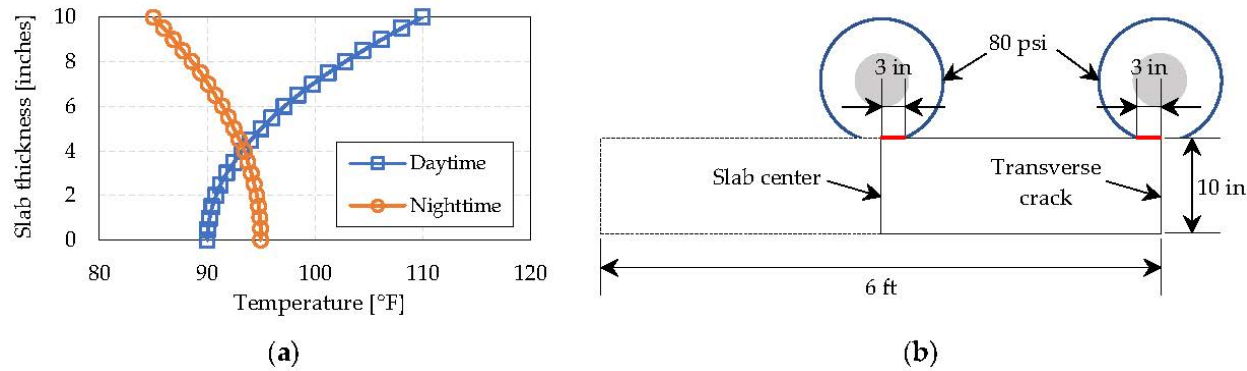
Figure 7. Loading conditions: ( a ) temperature gradient and ( b ) vehicle wheel loading (1 in = 25.4 mm, °C = (°F − 32)/1.8, 1 psi = 6.89 kPa).